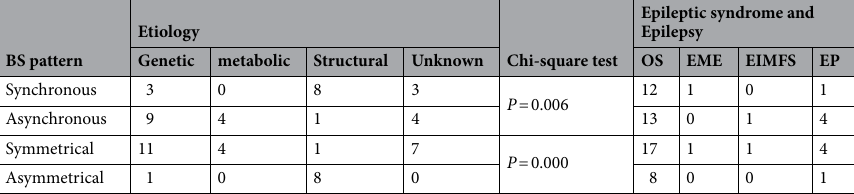
Table 3. The relationship between EEG features and epileptic characteristics. BS Burst suppression, OS Ohtahara syndrome, EME Early myoclonic encephalopathy, EIMFS Epilepsy of infancy with migrating focal seizure, EP Epilepsy.